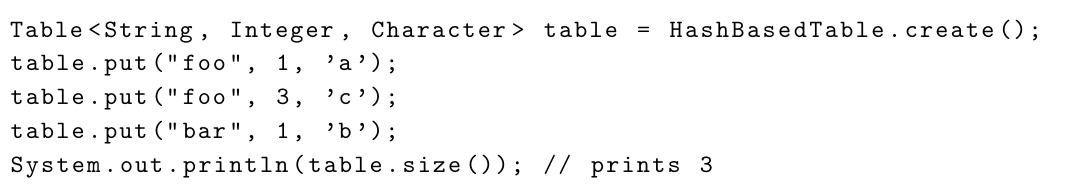
table.put("foo", 1, ’a’); table.put("foo", 3, ’c’); table.put("bar", 1,